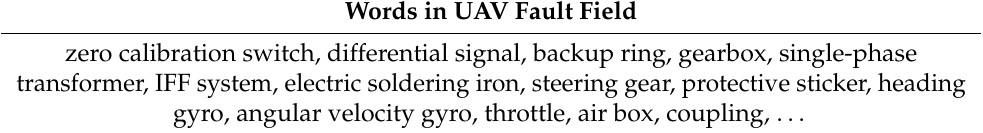
Table 1. Example of UAV fault domain professional dictionary based on expert experience and professional